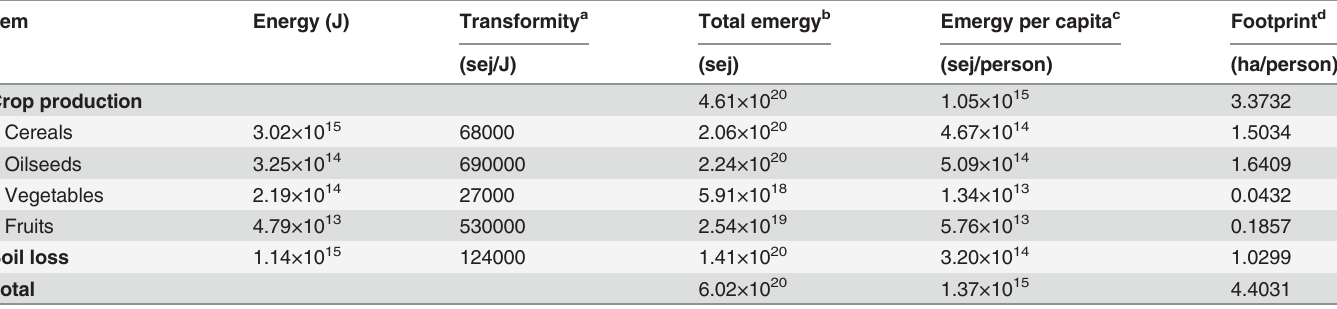
Table 2. Calculation of 2009 footprint for Yuanzhou County, Ningxia Hui Autonomous Region, China using the EEF